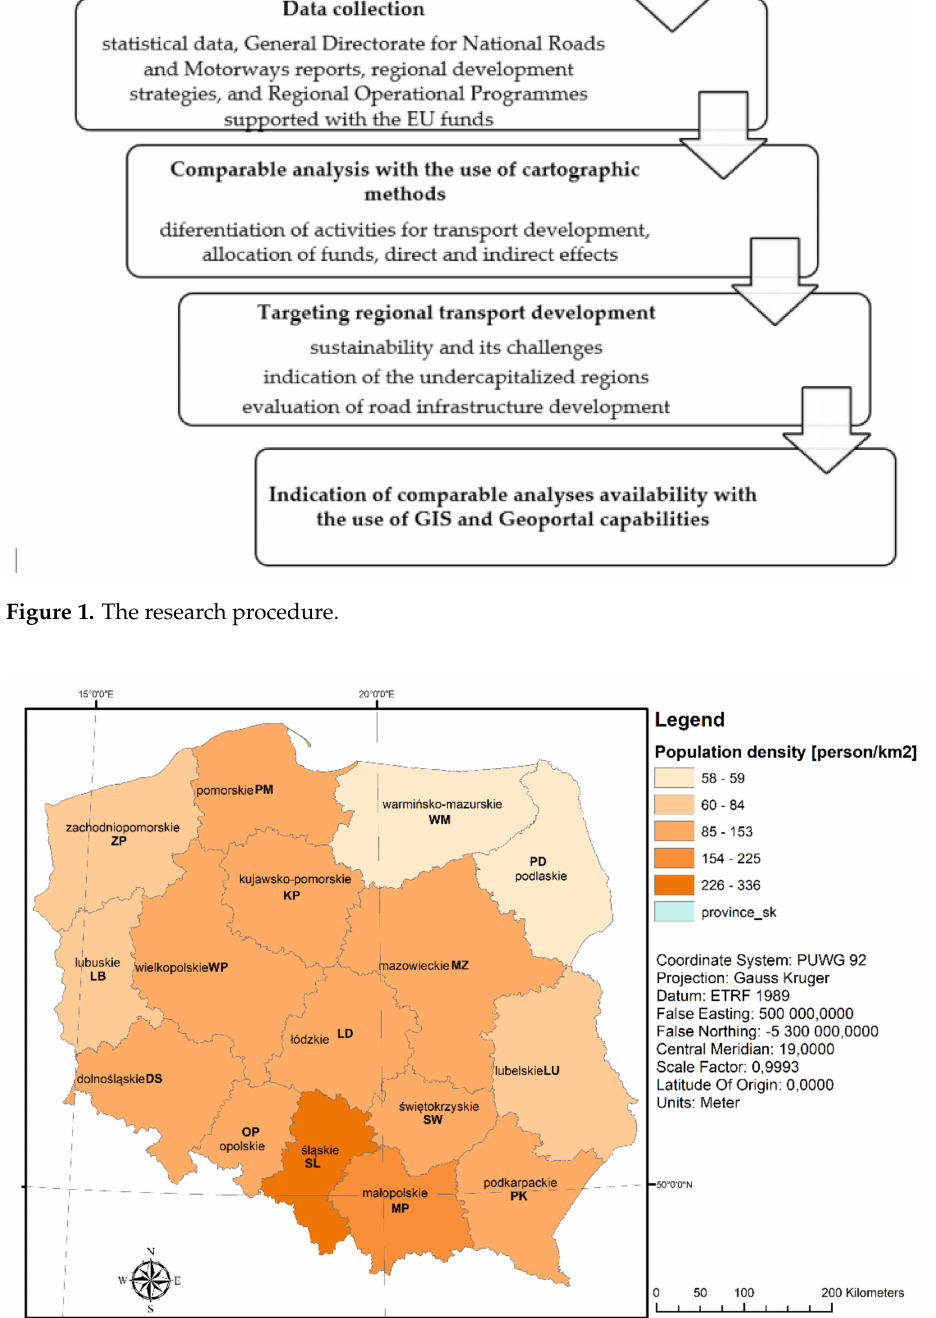
Figure 2. The study area with population density. Source: the authors, based on [56]. After EU accession in 2004, Polish provinces were the area of large transport invest- ments, with a special emphasis on road network improvement. Polish national and regional authorities implemented numerous road infrastructure projects, with major investments in express road networks. These resulted in the increase of statistical measures reported